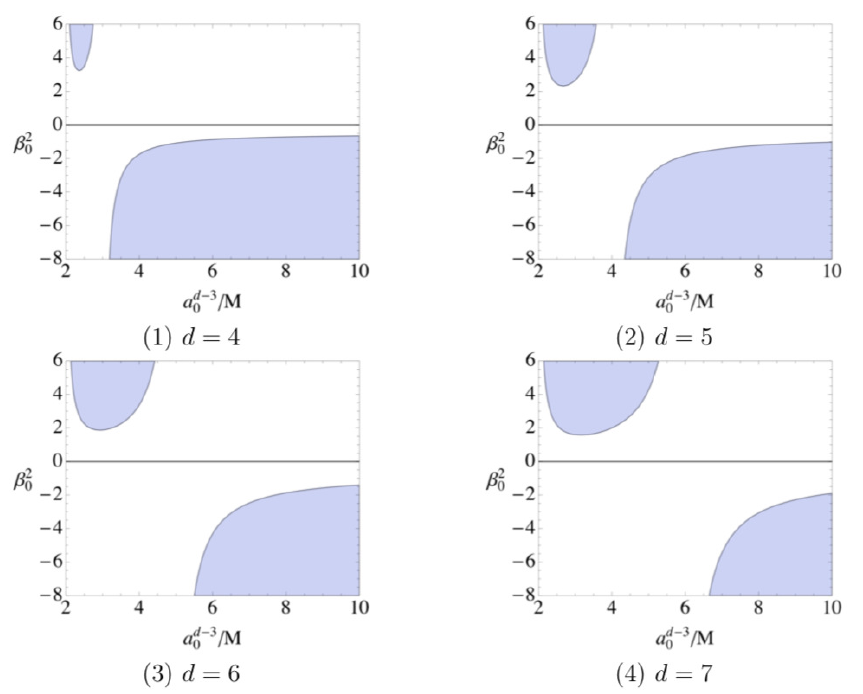
Figure 15. A higher dimensional generalization. The shaded regions represent the